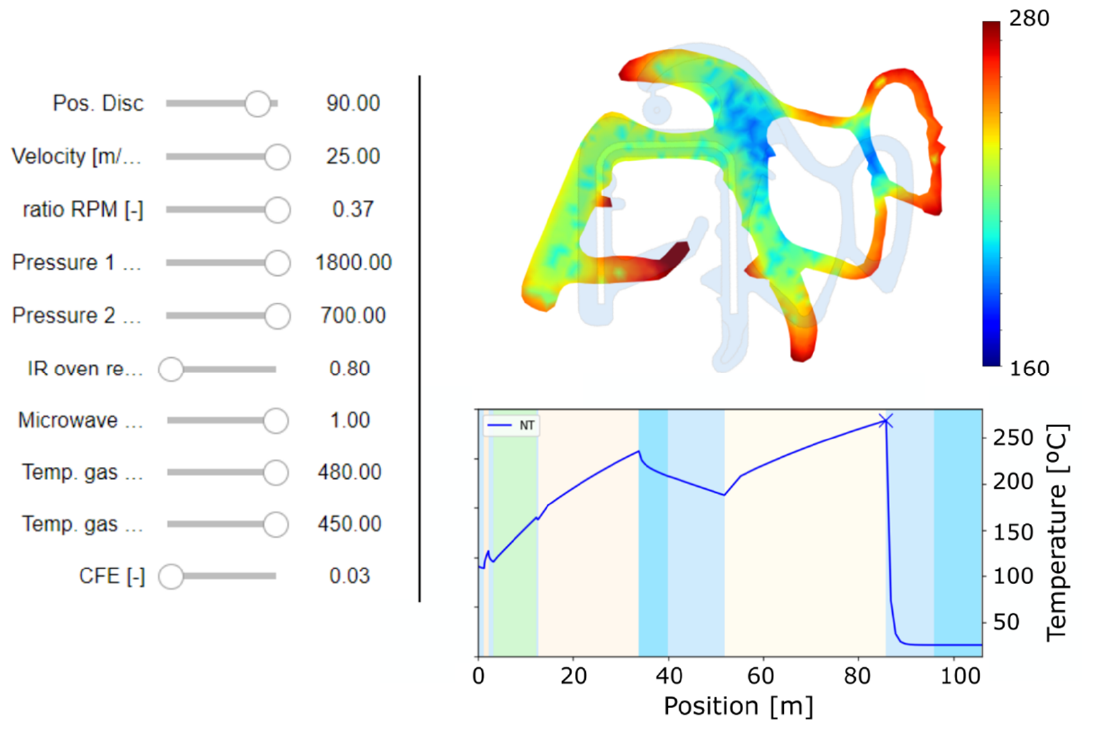
Figure 7. Numerical tool to visualize and explore results from the process subrogate model.